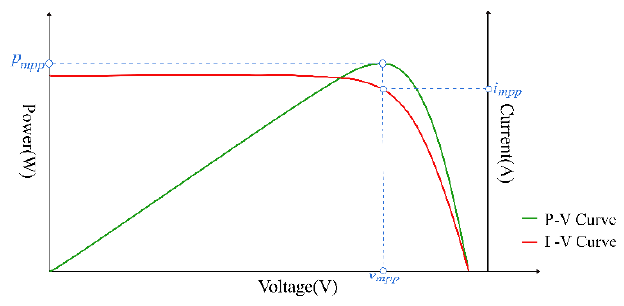
Figure 4. P-V, I-V characteristic curves .